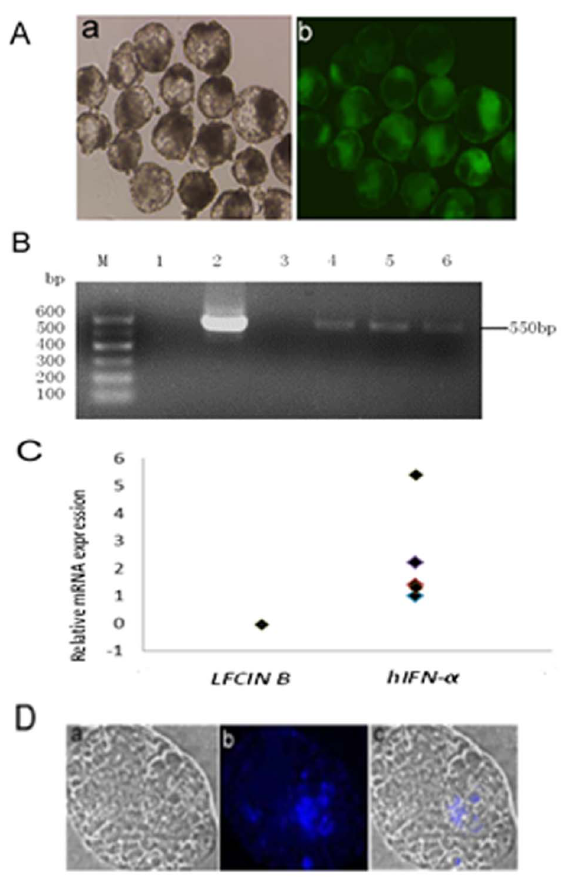
Figure 4. Detection of hIFN- a and LFCIN B expressed in transgenic SCNT embryos by PCR and immunofluorescence. (A) zona-free transgenic SCNT blastocyst ( 6 100). Panel a, under light microscopy; Panel b, under fluorescence microscopy. Green: GFP. (B) PCR analysis of the hIFN- a gene in transgenic SCNT embryos. Lane M, 100 bp molecular weight marker; lane 1, water as template; lane 2, pIRSEneo- IFN -bCP- LFCINB - EGFP as template; lane 3, non-transgenic SCNT embryos DNA as template; lanes 4, 5, and 6, hIFN- a transgenic SCNT embryos. (C) Real-time RT-PCR analysis of mRNA expression levels of hIFN- a (n=6) and LFCIN B (n=6) in transgenic SCNT embryos, with results normalized to expression levels of GAPDH . (D) Immunofluores- cence analysis of hIFN- a expressed in transgenic SCNT embryos ( 6 200, n=10). Transgenic SCNT blastocysts were stained with V450-conjugat- ed antibody against hIFN- a -2b. Panel a, under light microscopy; Panel b, under fluorescence microscopy with Violet laser Em Max at 450 nm; Panel c, merged images, with blue showing V450 fluorescence.